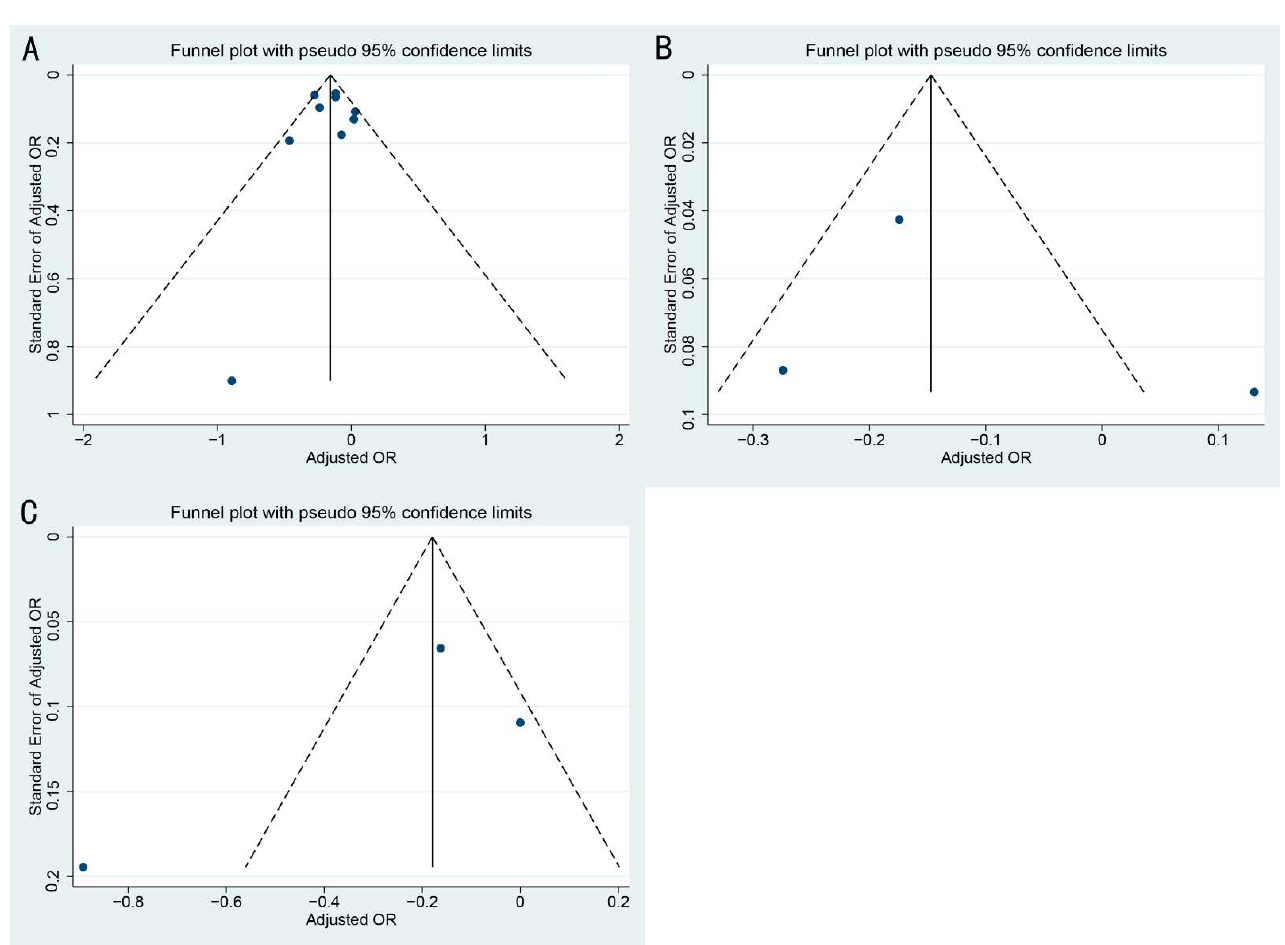
Figure 4. Funnel plots for the associations between influenza vaccination and SARS-CoV-2 infection and clinical outcomes: (A) adjusted OR of SARS-CoV-2 infection ( B ) mortality ( C ) hospitalization. Table 5. Summary of publication bias on the association between influenza vaccination and SARS- CoV-2 infection and clinical outcomes.